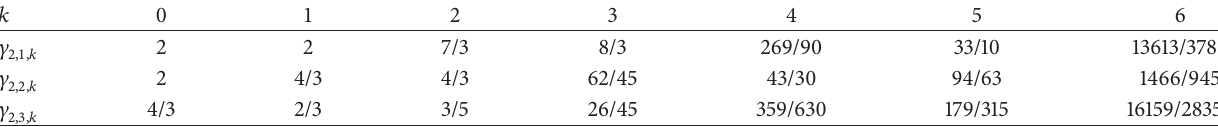
Table 1: The explicit integration coefficients for 𝑘 from 0 to 6 (for 𝑦 𝑛+2 ).